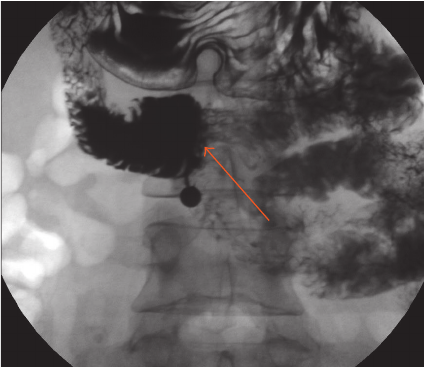
Figure 1: Duodenal compression of the third part (orange arrow) with delay in contrast passage (Case Report One).